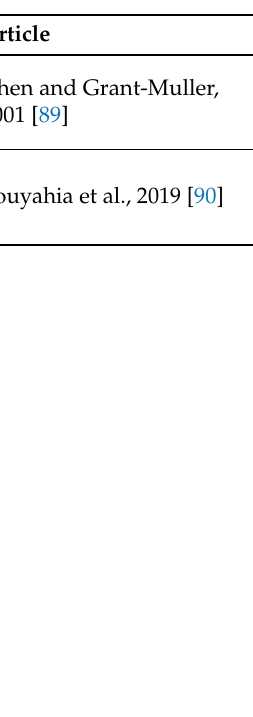
Table 15. Summary of the works found using